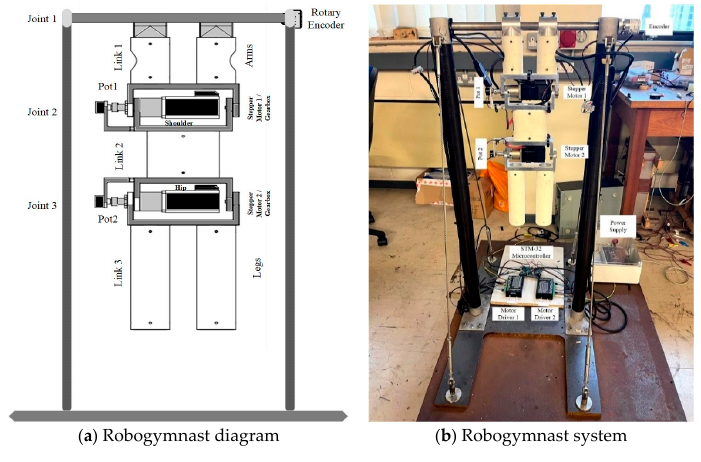
Figure 1. Robogymnast.